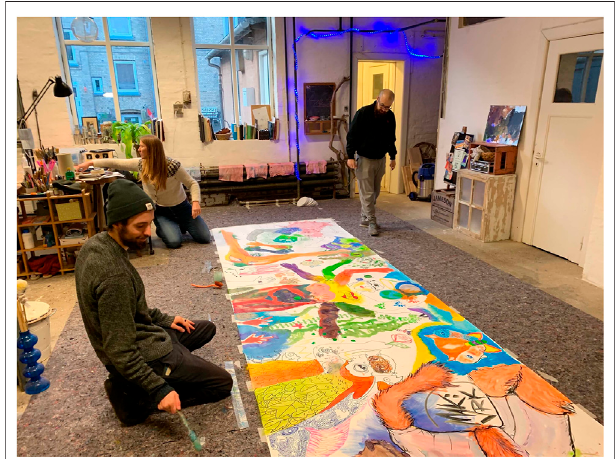
FIGURE 4 | The research team engaged in weekly workshops at the artist ’ s studio, engaging in collaborative drawing and painting tasks, including collaborating on a large physical